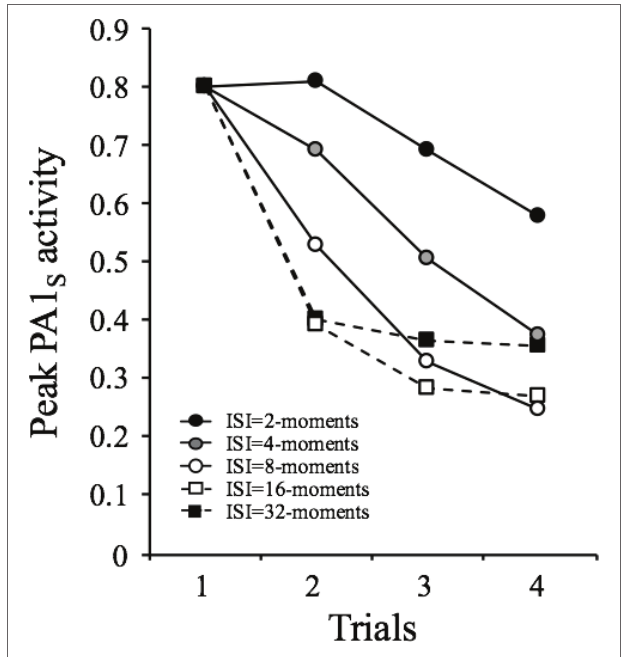
FIGURE 3 | Simulated peak PA1 S activity over 4 presentations of a 1-moment stimulus at inter-stimulus intervals ranging from 2 to 32